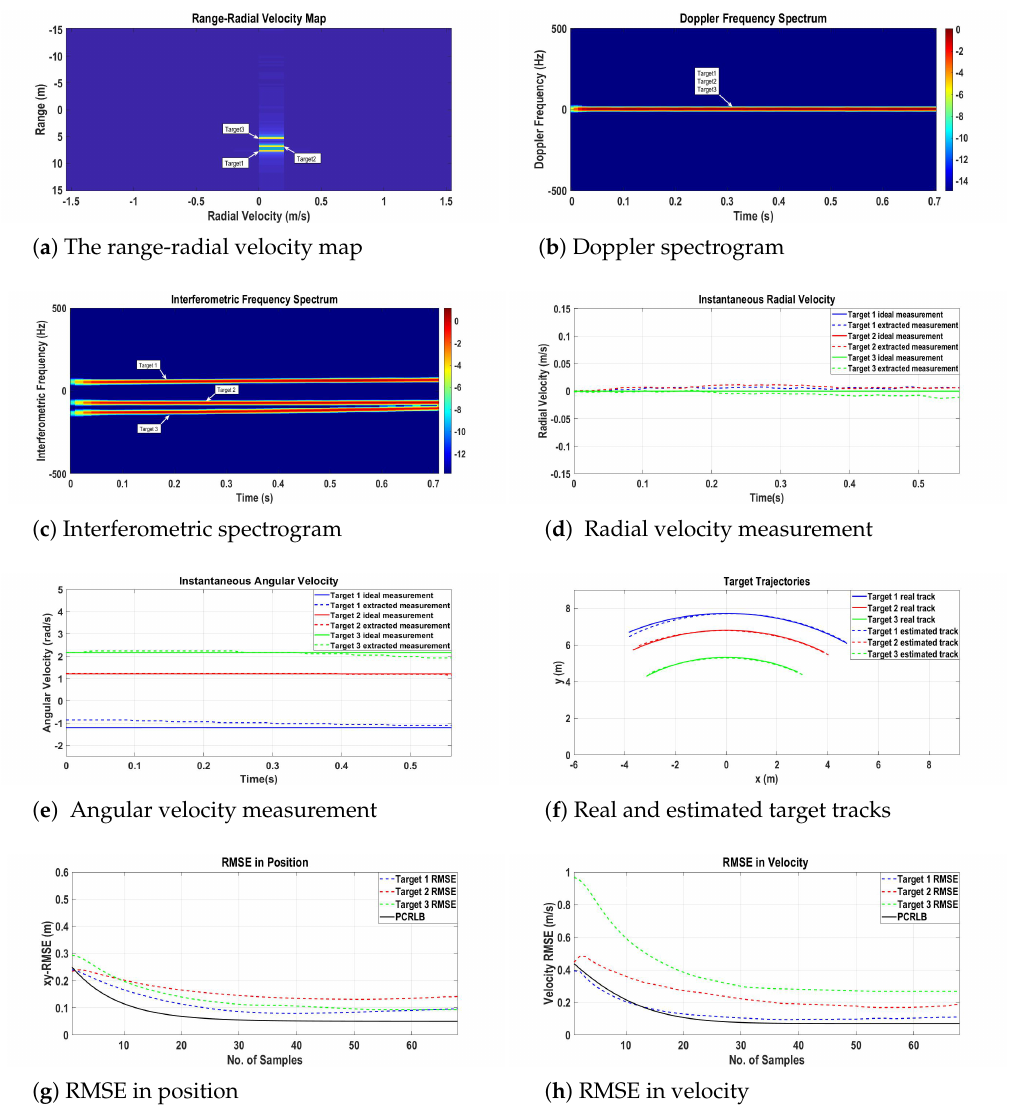
Figure 6. Scenario 1: Three non-maneuvering targets moving tangential to radar